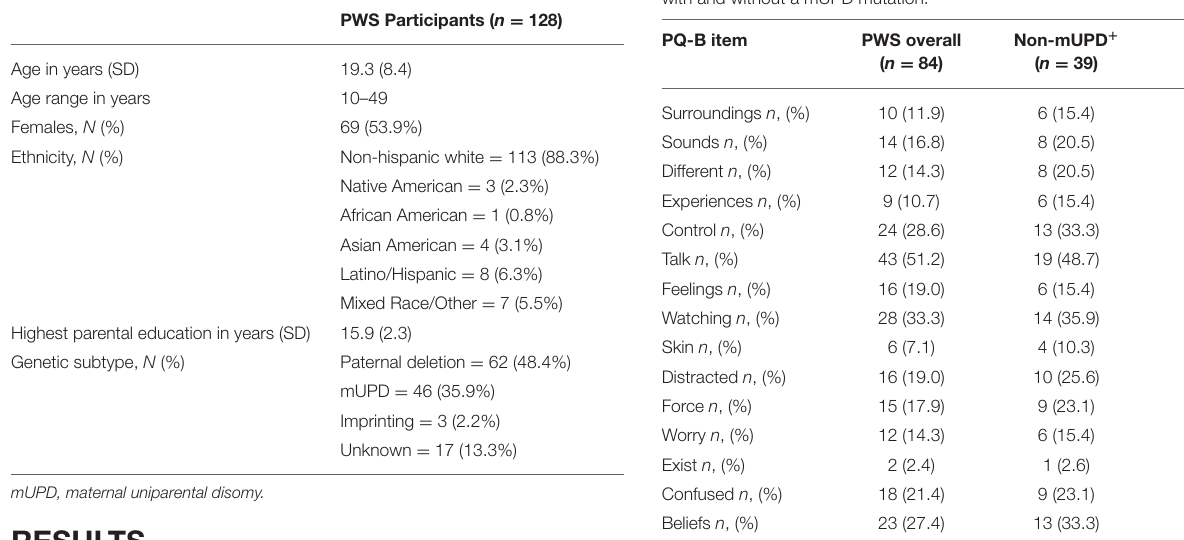
TABLE 2 | Participant demographics. TABLE 3 | Frequency of PQ-B items endorsed in all PWS subjects and subjects